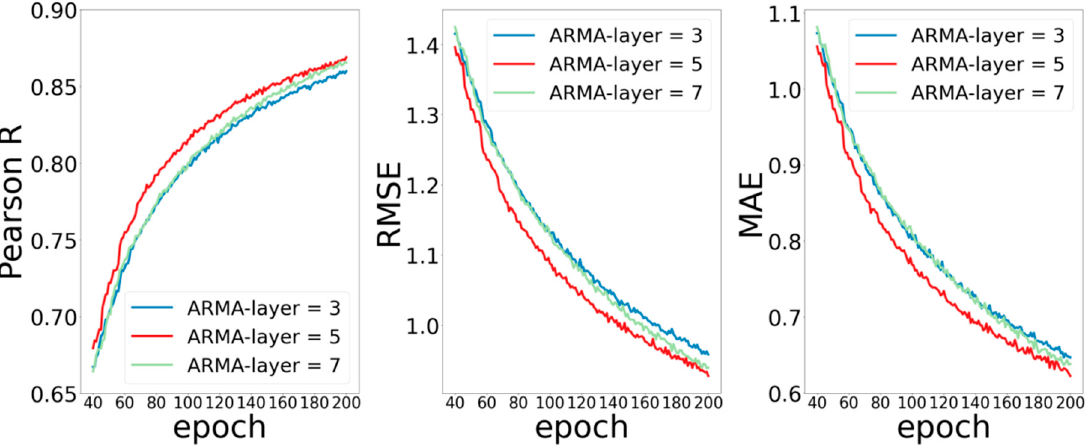
Figure 3. Curves of Pearson R, RMSE, and MAE for different ARMA layers.